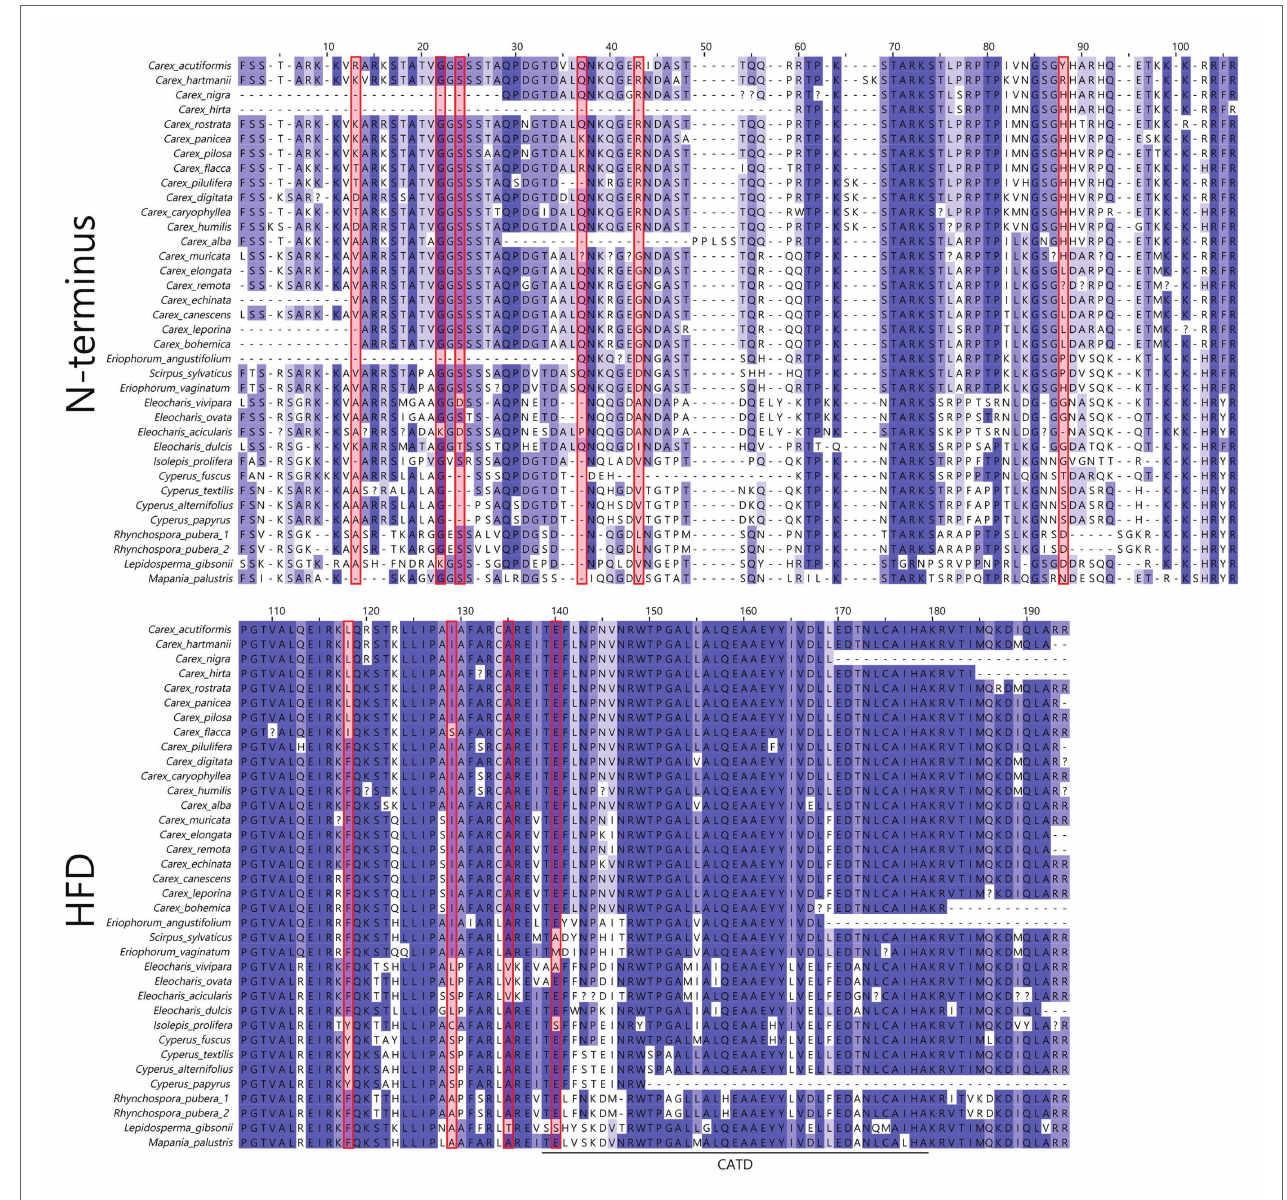
FIGURE 1 | Non-masked amino-acid alignment of Cyperaceae CenH3. Positions of positively selected codons in CenH3 are marked by red rectangles. The numbers of amino acids correspond to the numbers of codons from the MEME output ( Supplementary Table S6 ). HFD, histone fold domain; CATD, centromere targeting